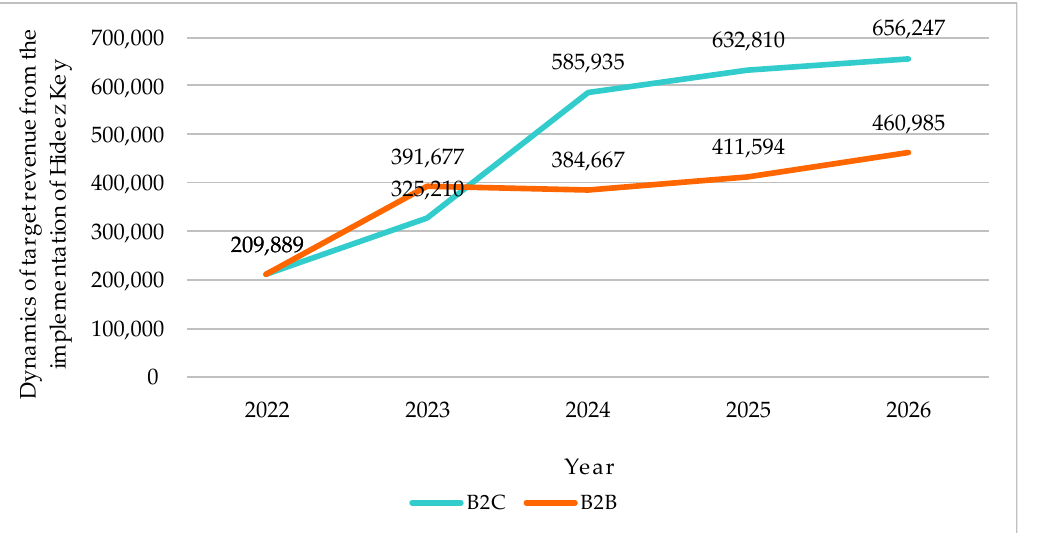
Figure 4. The structure of expenses for the promotion of innovative products of Hideez in the dy ‐ namics during 2022–2026, US dollars. In February 2021, Hideez Technology LTD signed a distribution agreement with ERC to promote Hideez Key in Poland. According to preliminary estimates, the main financial indicators of Hideez Key sales revenue and gross profit of Hideez Technology LTD are projected to grow rapidly during 2022–2026 (Figure 5).